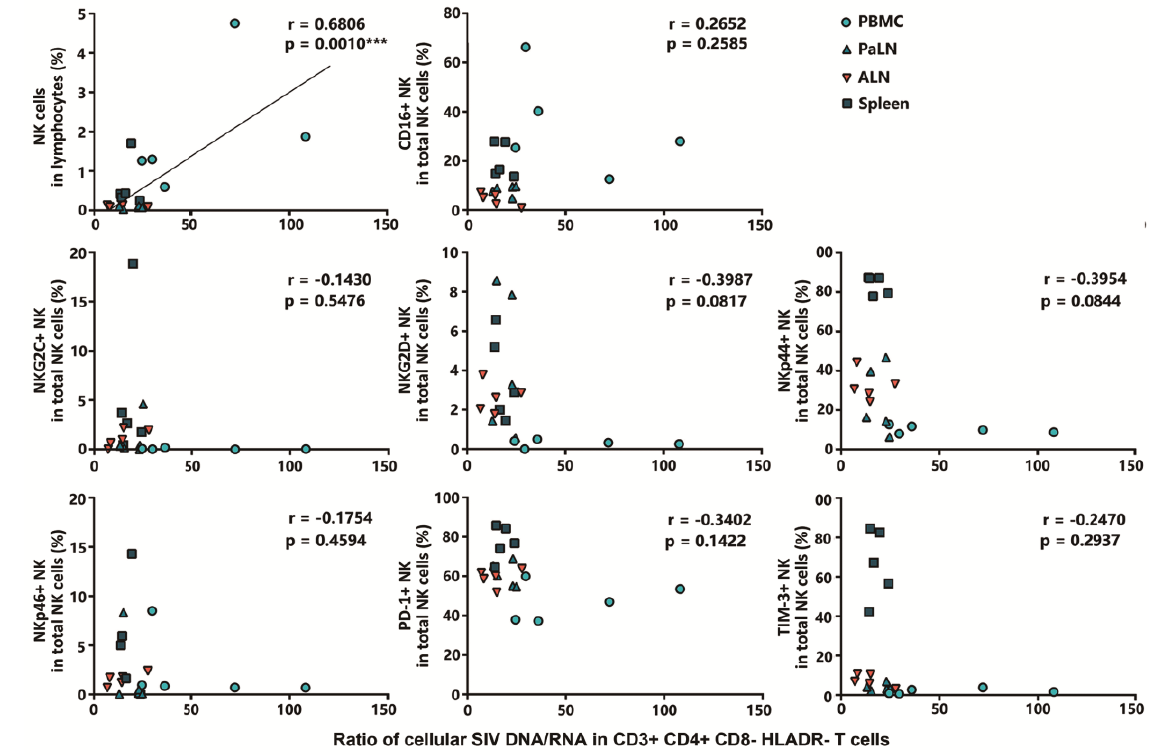
Figure 5. Correlation analysis between frequencies of NK cells in lymphocytes, percentages of cytotoxic NK subsets, phenotypic indicators of NK cells, and cellular SIV DNA/RNA ratios in CD3 + CD4 + CD8 - HLADR - T cells. The correlation was performed using the Spearman rank correlation coefficient test. p values < 0.05 were considered a statistical difference (***, p < 0.001).